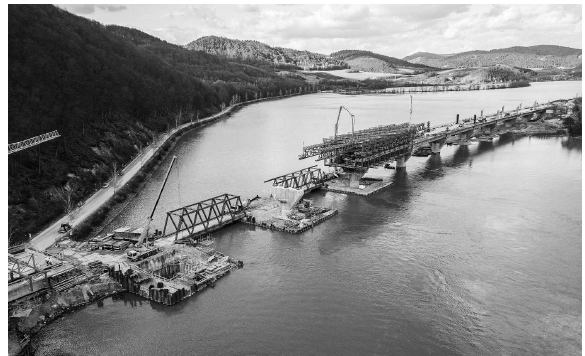
Figure 1. New railway bridge over the Nosicka Dam during